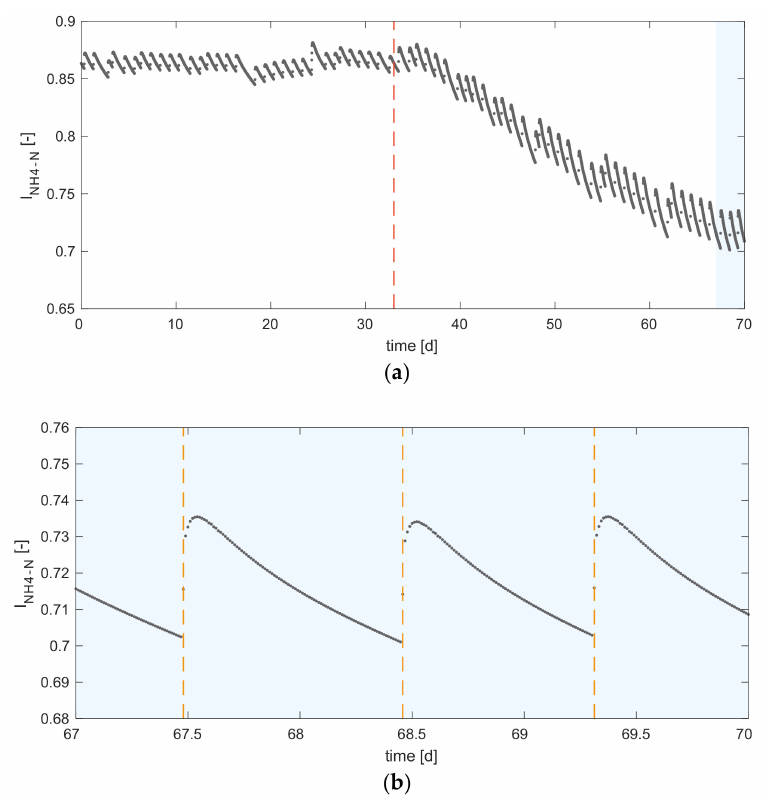
Figure 4. ( a ) Modelled ammonium inhibition for reactor R1. Simulation period of 70 days and ( b ) three-day selection. The red dashed line marks the time for load increase. Yellow dashed lines mark the time for